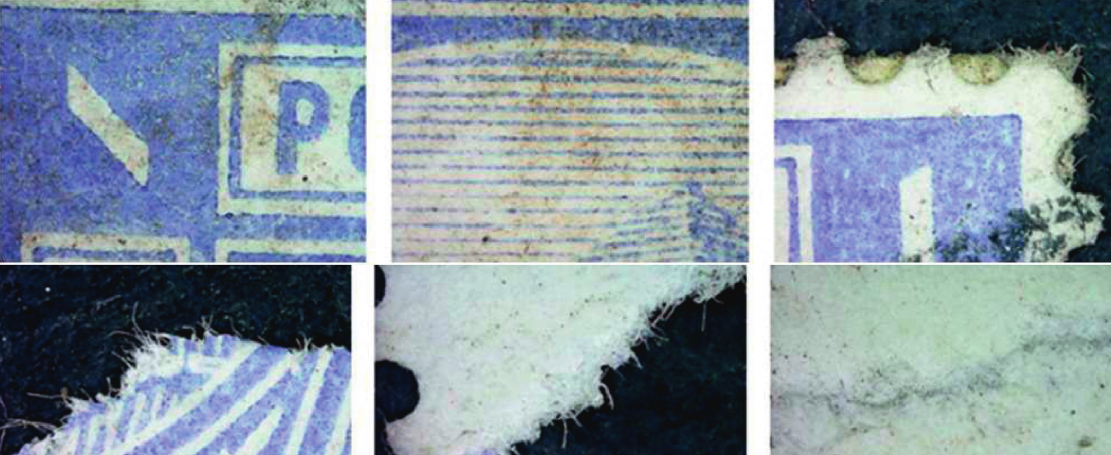
Figure 5: Various defects in red stamp fibers at